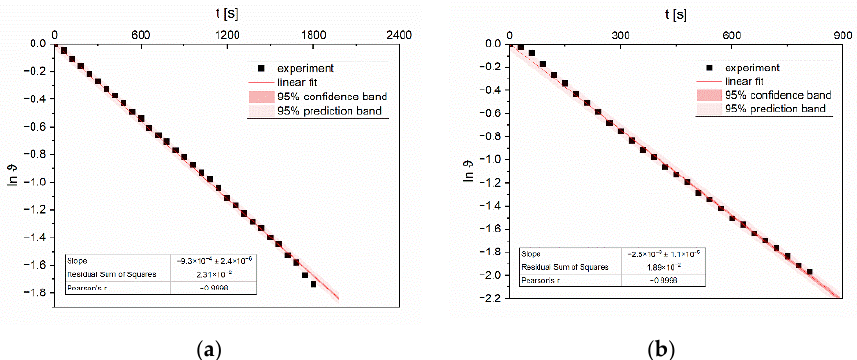
Figure 4. The logarithm of dimensionless temperature ϑ versus time—exemplary results for cylindrical sample, air temperature 40 °C, US power: ( a ) 0 W ( b ) 200 W.